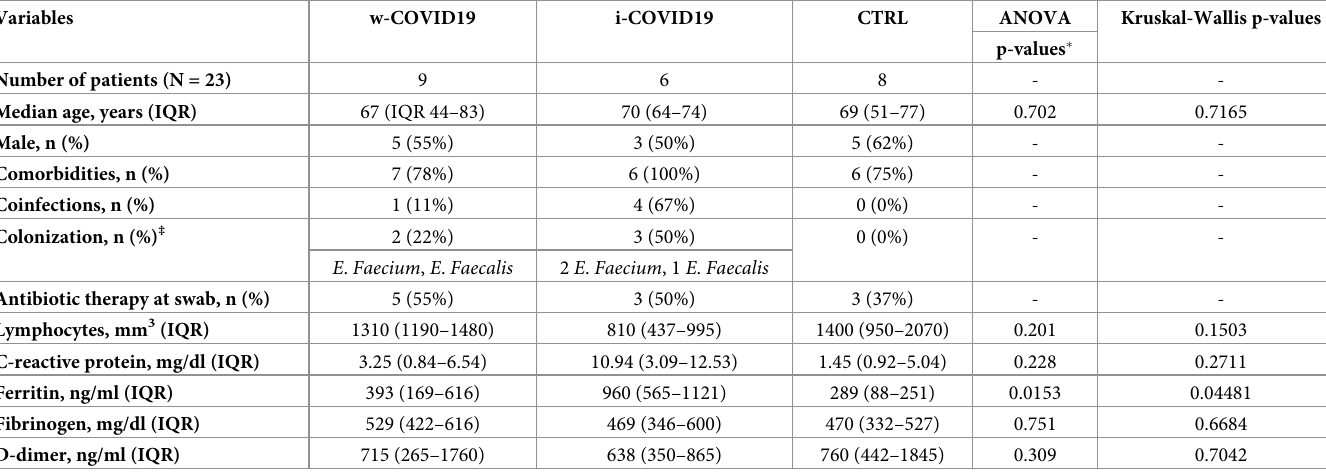
Table 1. Clinical and serologic data of the 23 enrolled patients.